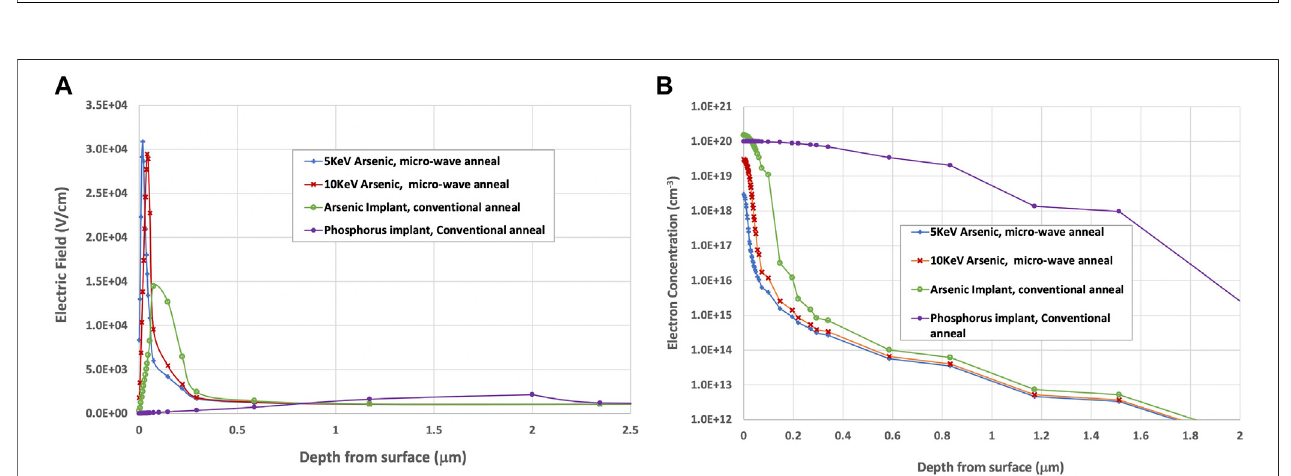
FIGURE8| Activateddopantpro fi lesforfourentrancewindowpro fi lessimulatedforthiswork.Thespacingofthedatapointsre fl ectsthegridspacinginthevertical direction, which is about 5 nm for the fi rst 50 nm from the surface.